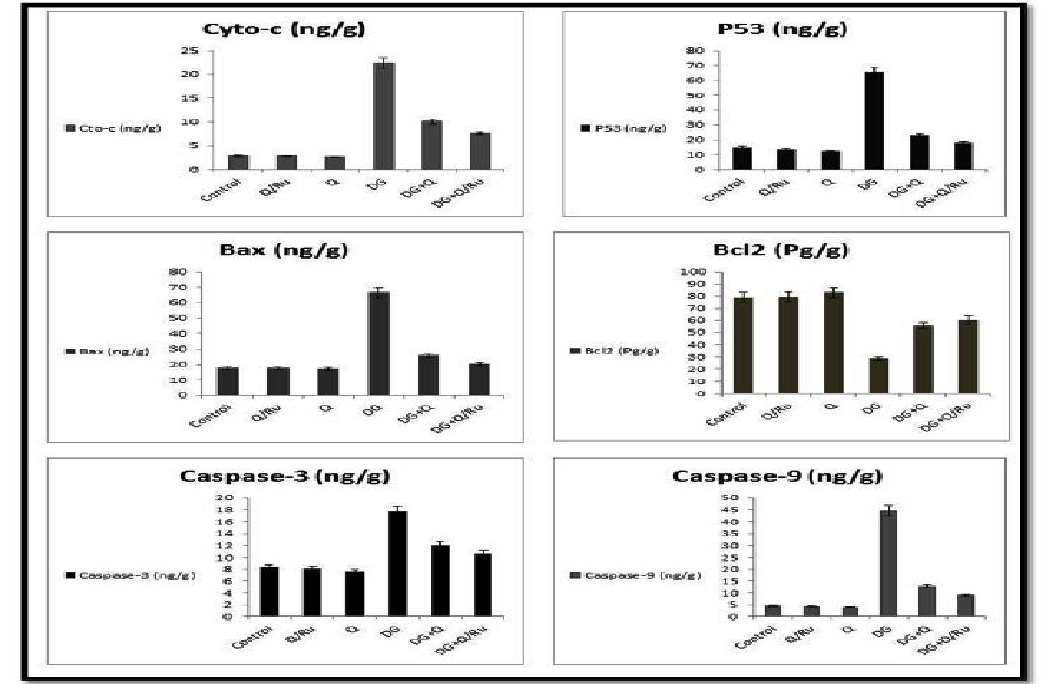
Figure 9. Effect of DG, Q and Ru III /Q alone or either combined on the quantitative expression of cyto-c, P53, Bax, BCl2, caspase-3 and caspase-9 in the brain tissue homogenates.